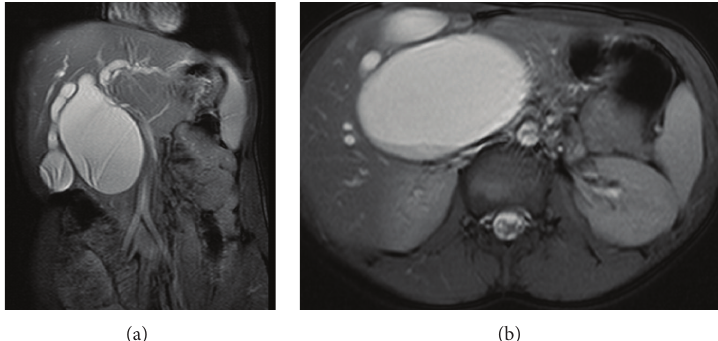
Figure 2: (a) MRCP showing type I-A saccular choledochal cyst in patient 4 (Table 1). (b) MRCP (cross section) showing large type I-A saccular choledochal cyst in patient 4 (Table